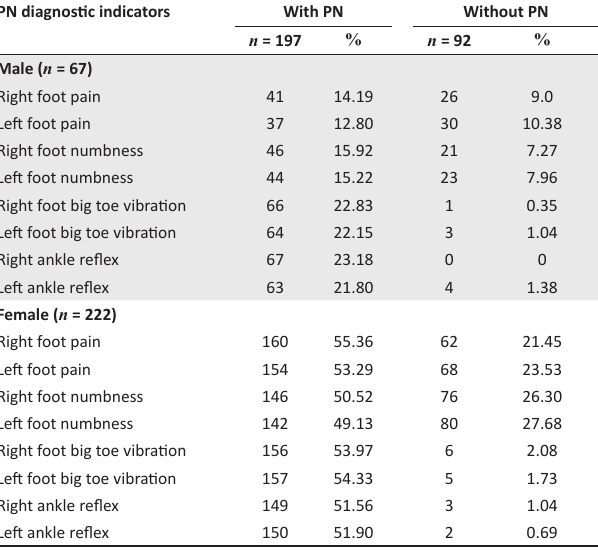
TABLE 2: Prevalence of peripheral neuropathy amongst male and female participants on